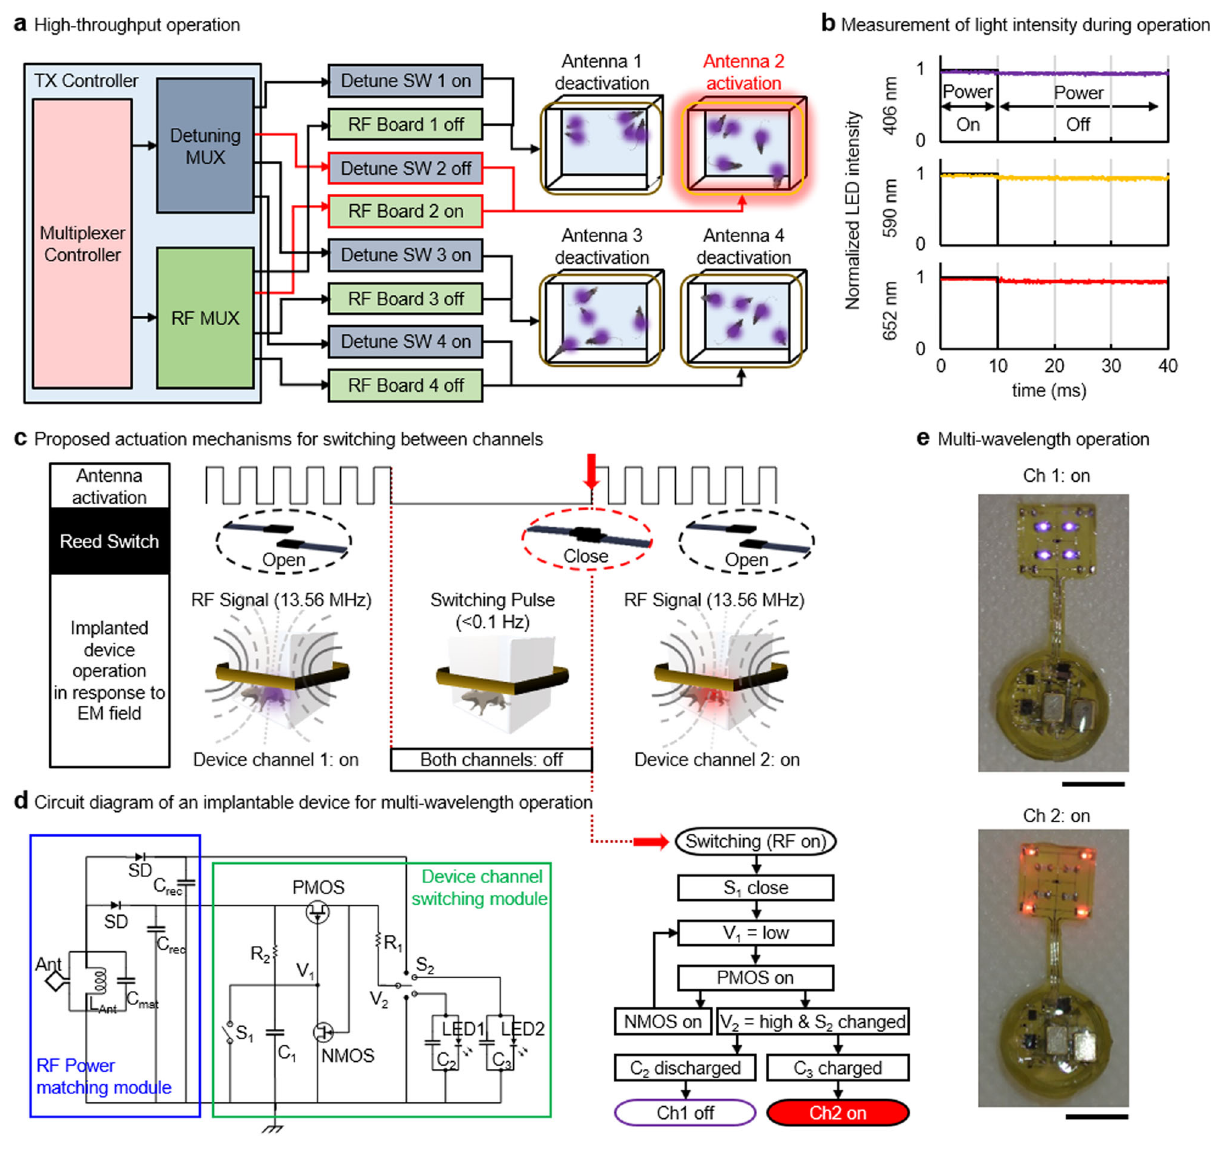
Fig. 4 Characteristic of low-power multichannel wireless telemetry. a Functional block diagram of multi-cage control TX system. b Measurements of light intensity during the TX system operation. Devices maintain constant light intensity during operation. c Illustration of the proposed reed switched enabled actuation mechanism. d Circuit diagram of an implantable device for multi-wavelength operation. e Images of an implantable device with multi-wavelength operation; scale bar 5